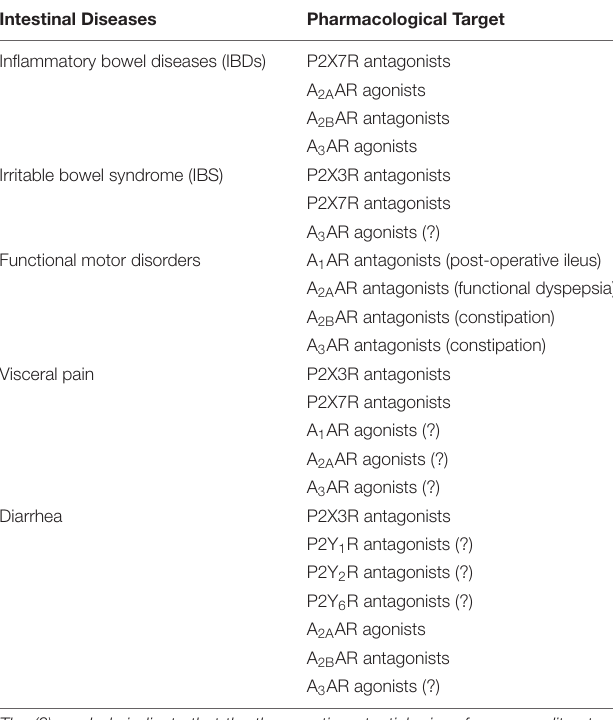
TABLE 1 | Promising pharmacological tools acting on purinergic receptors to manage intestinal